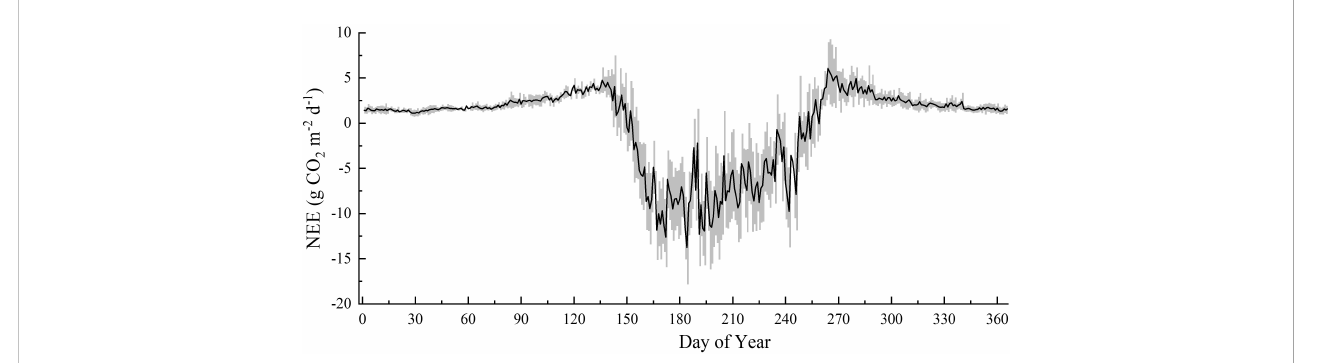
FIGURE 3 Average daily NEE (net ecosystem CO 2 exchange) seasonal variation from 2014 to